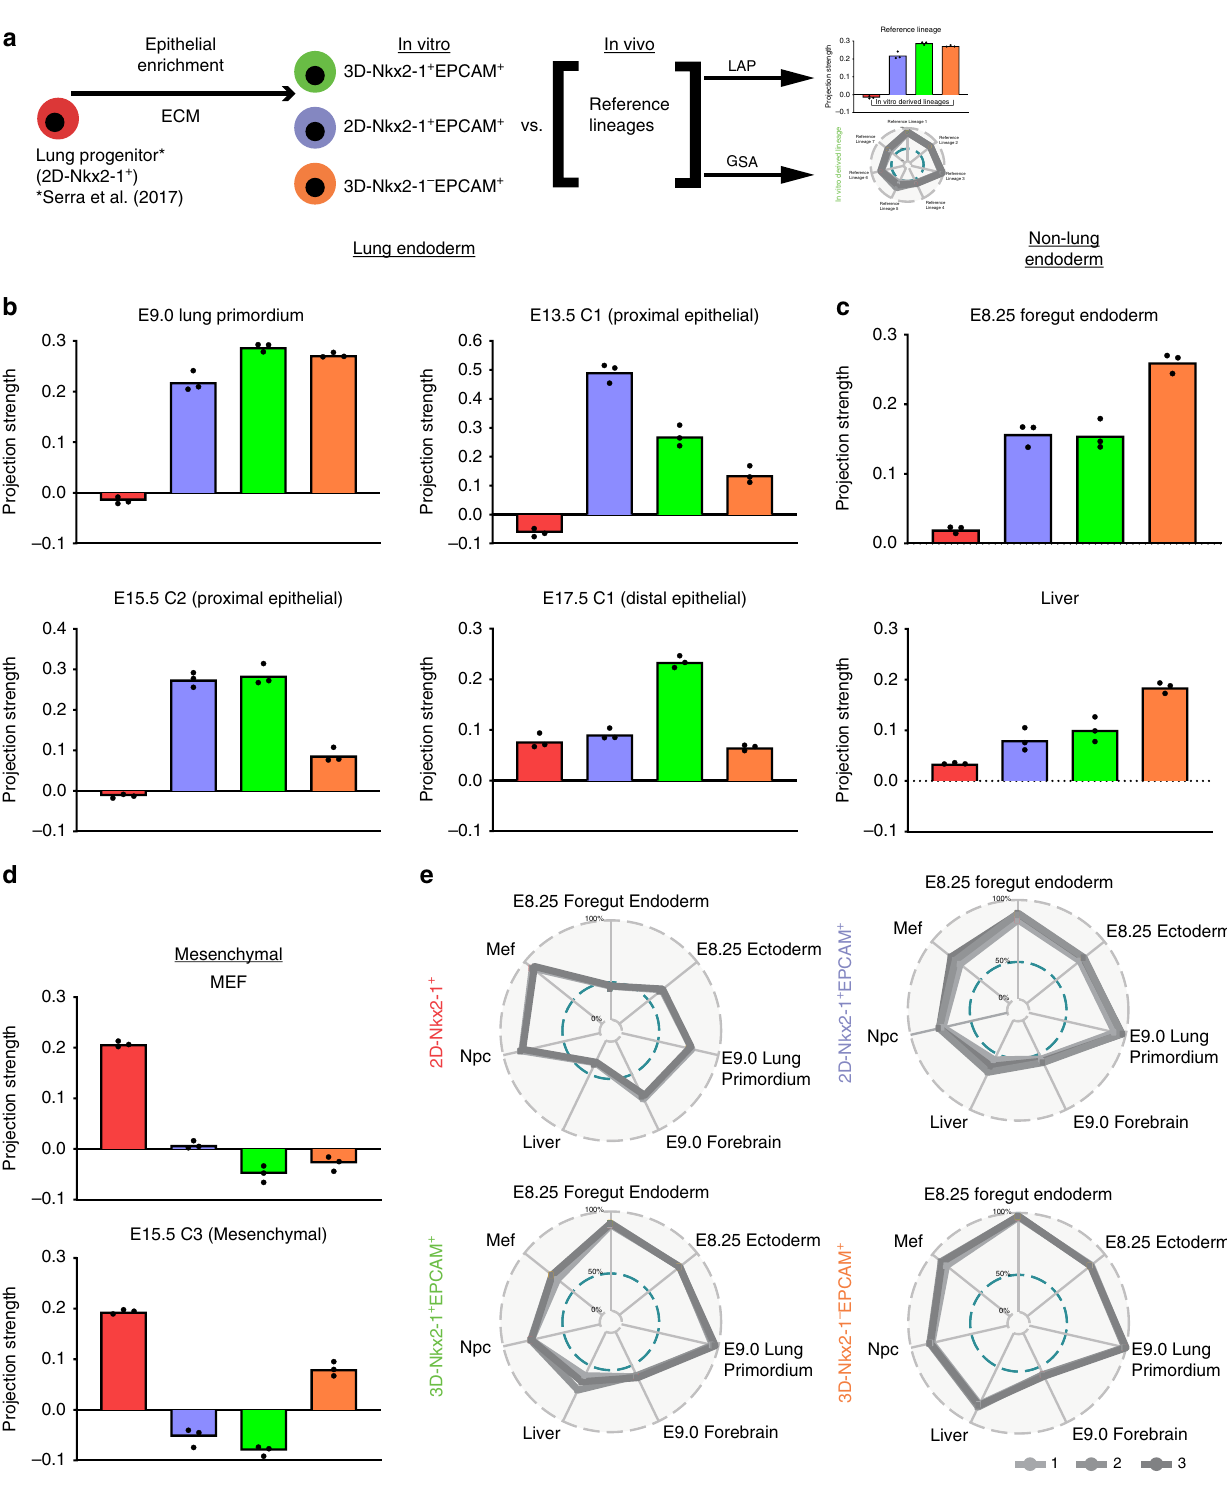
Fig. 6 Similarity analysis of in vitro PSC-derived and in vivo lung progenitors. a Schematic depicting the four types of in vitro PSC-derived progenitors using a lung speci fi cation cocktail (in vitro-derived lineages) and derivation of similarity scores to in vivo populations (reference lineages) via two methods, namely linear projection analysis (LAP) and gene set analysis (GSA) ( b – d ). Projections strength scores from LAP analysis for the four populations shown in a , including projections to lung endodermal populations ( b ), non-lung endoderm ( c ), and mesenchymal-like populations ( d ). Scores shown in Fig. 5a are re- plotted here for comparison purposes. e Projection scores from gene set analysis using the reference cell populations from b – d and Supplementary Fig. 7A with bulk RNA-Seq